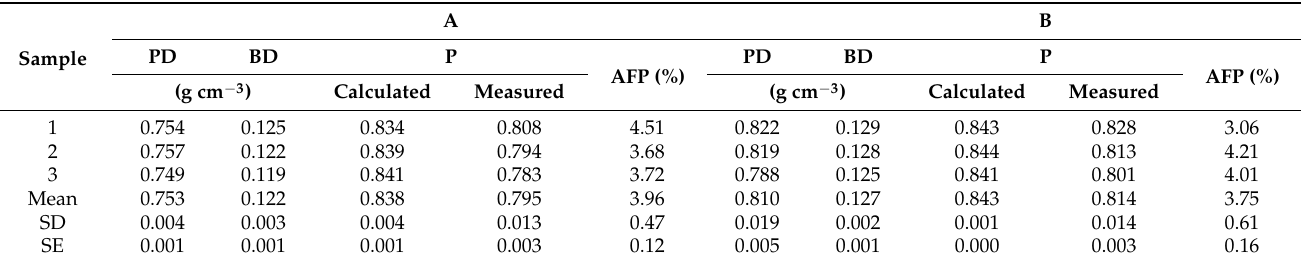
Table 3. Particle density, bulk density, calculated and measured porosity, and air-filled porosity for A and B.